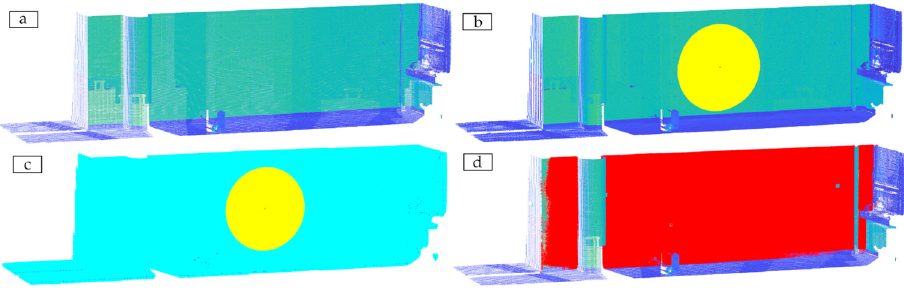
Figure 4. Plane segmentation procedure: ( a ) imput point cloud, ( b ) seed point and the 102,400 nearest neighbors, ( c ) 1,638,400 nearest neighbors, ( d ) inlier points.